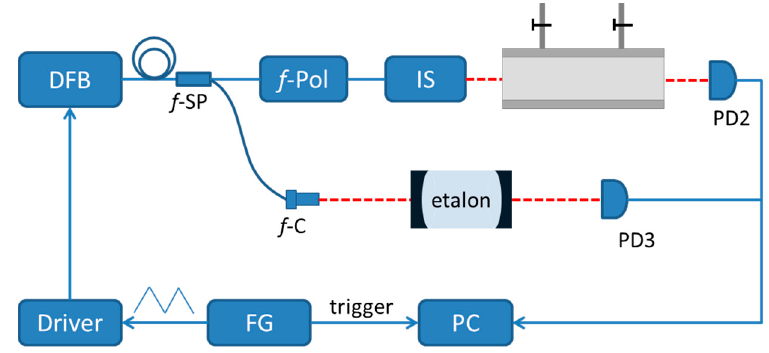
Figure 4. Schematic diagram of the DFB-laser-based intensity-stabilized fast-scanned direct absorption (IS-FS-DAS) spectroscopy instrumentation used in this work. IS: intensity stabilization system; FG: function generation; PC: personal computer.